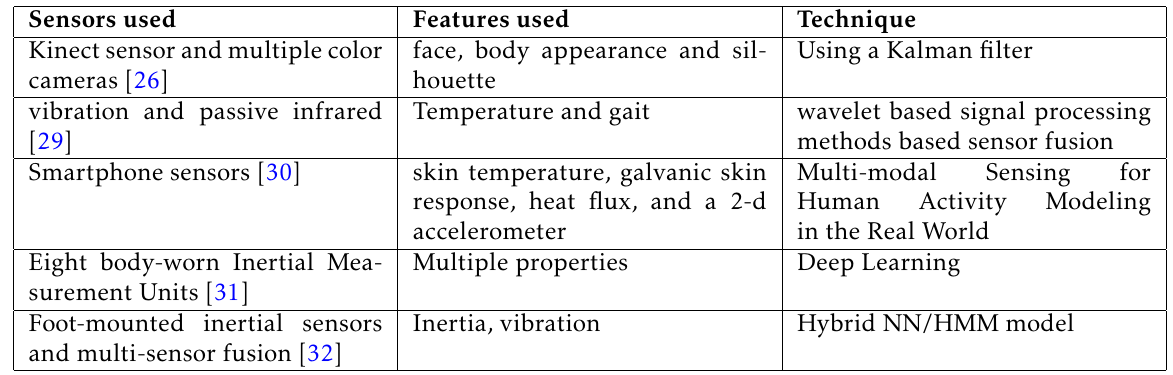
Table 1. Approaches for sensor